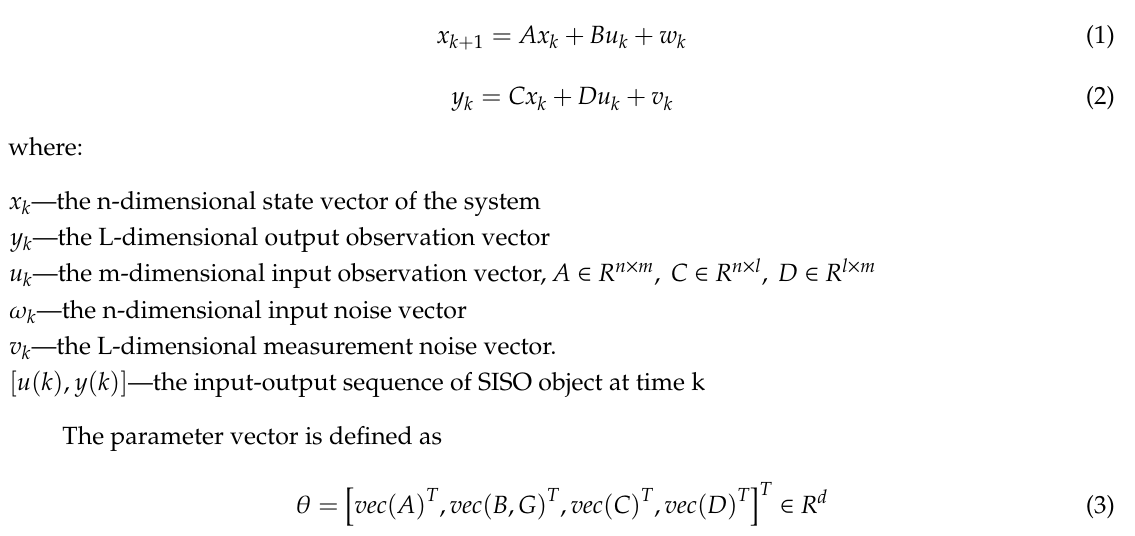
Figure 6. Experimental schematic